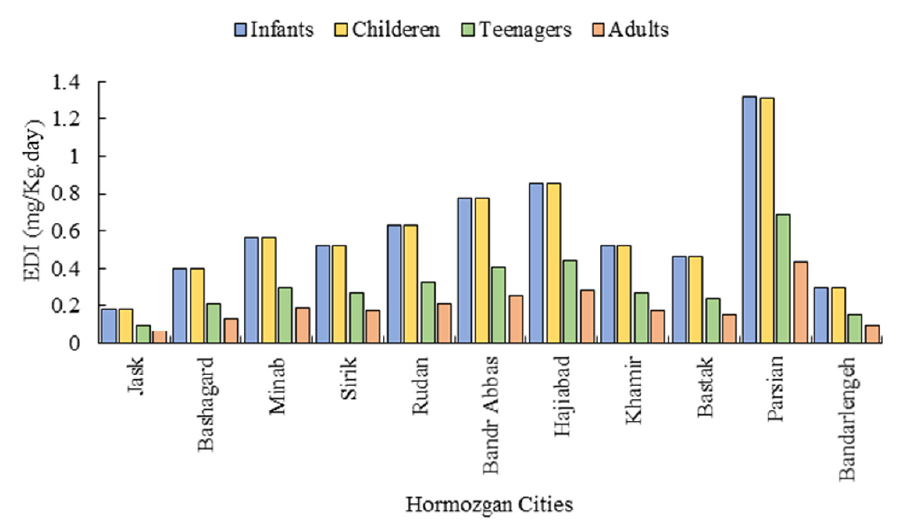
Figure 5. EDI Values for exposure to nitrate in cities of Hormozgan province in different age groups.